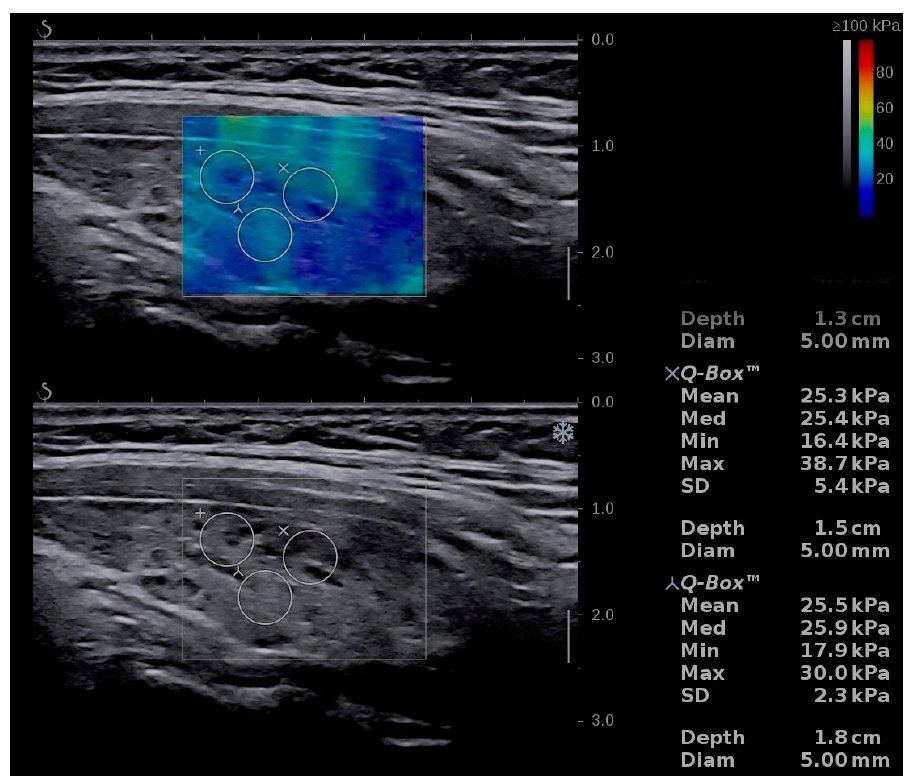
Figure 3. Shear-wave elastography of an adult patient with CAT, 36 years old, female.